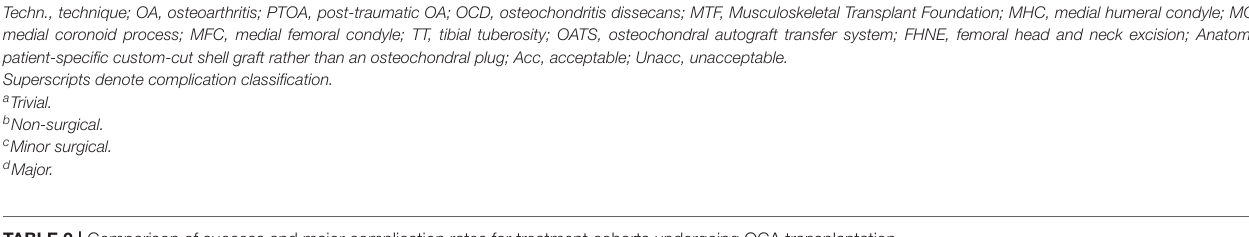
TABLE 2 | Comparison of success and major complication rates for treatment cohorts undergoing OCA transplantation.